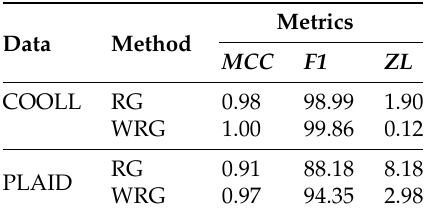
Table 2. Results comparision between WRG and RG on PLAID and COOLL dataset.